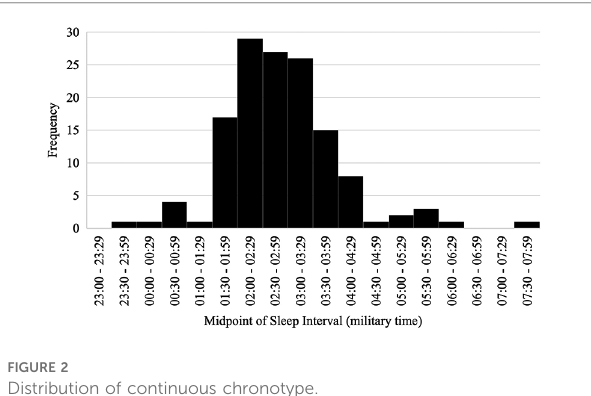
FIGURE 2 Distribution of continuous